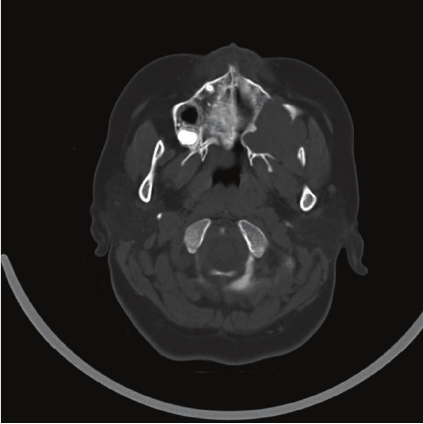
Figure 5: Axial section of CT scan showing osteolytic changes.